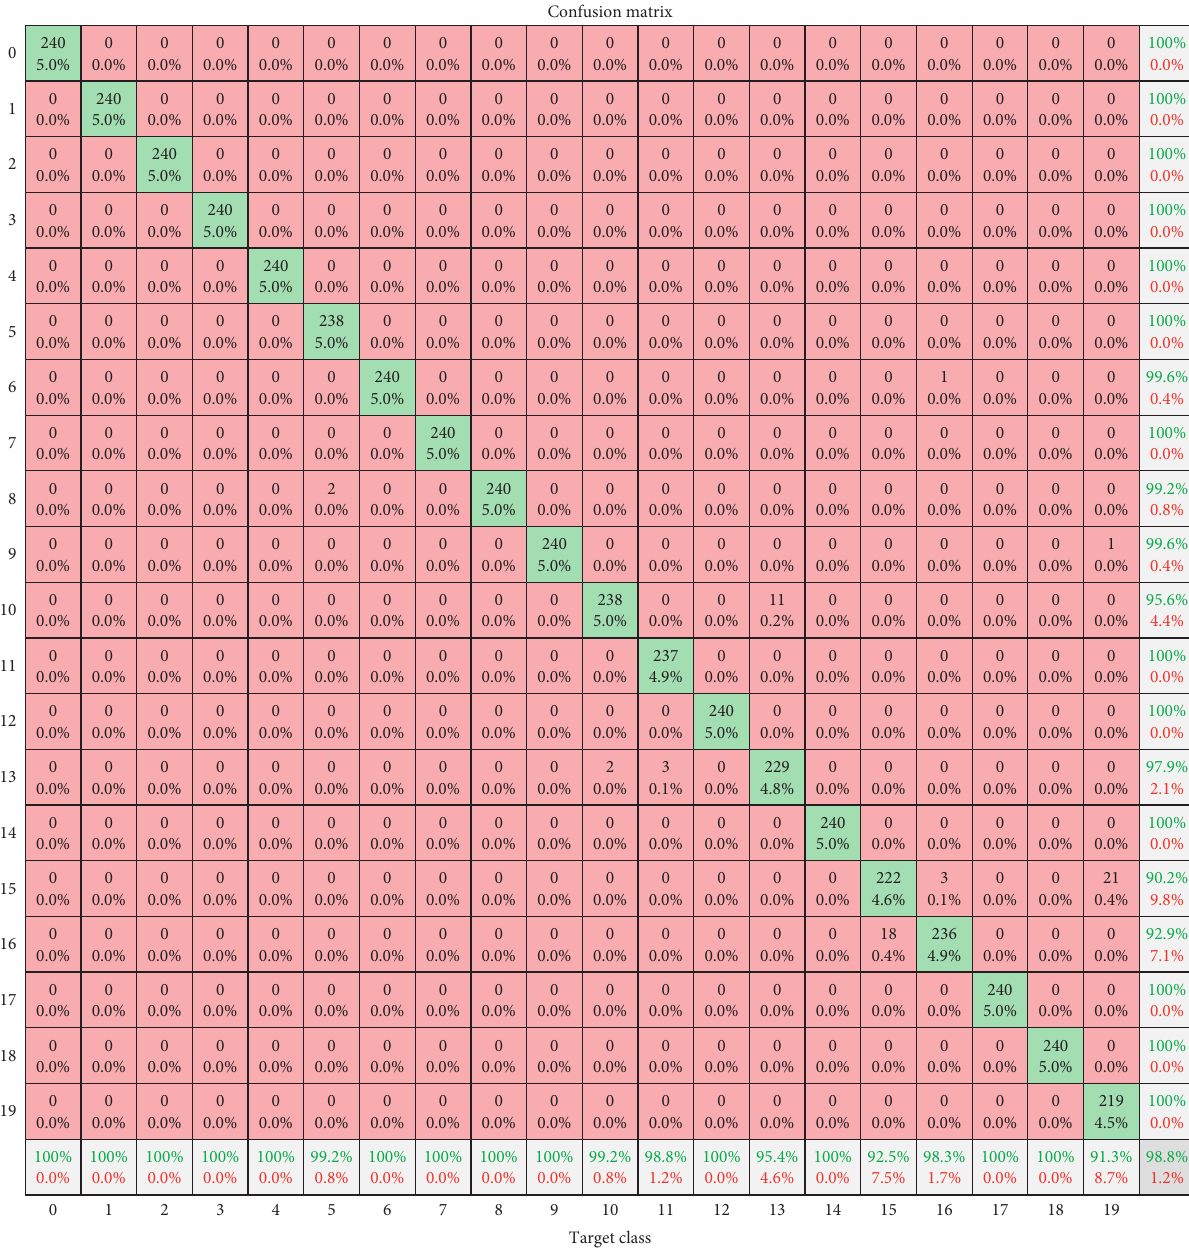
Figure 13: Confusion matrix of fine-grained class recognition using